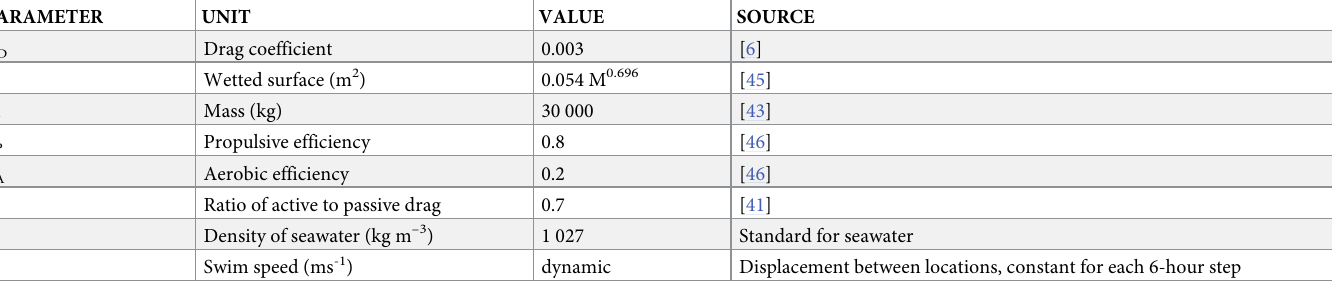
Table 1. Parameters, units and values used to calculate the energetic cost of migration. Parameter estimates were chosen in accordance with [6, 7]. PARAMETER UNIT VALUE SOURCE C D Drag coefficient 0.003 [6] S Wetted surface (m 2 ) 0.054 M 0.696 [45] M Mass (kg) 30 000 [43] E P Propulsive efficiency 0.8 [46] E A Aerobic efficiency 0.2 [46] λ Ratio of active to passive drag 0.7 [41] P Density of seawater (kg m –3 ) 1 027 Standard for seawater V Swim speed (ms -1 ) dynamic Displacement between locations, constant for each 6-hour